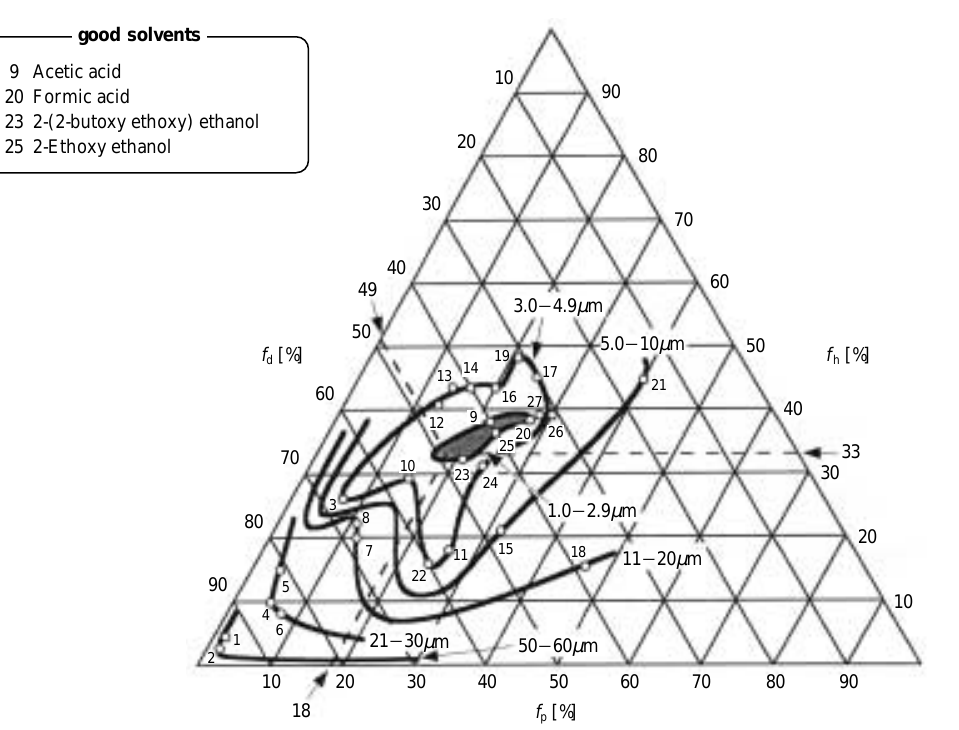
Fig. 4 Isometric particle lines on triangular chart for TiO 2 (Each number means a solvent listed in Table 1